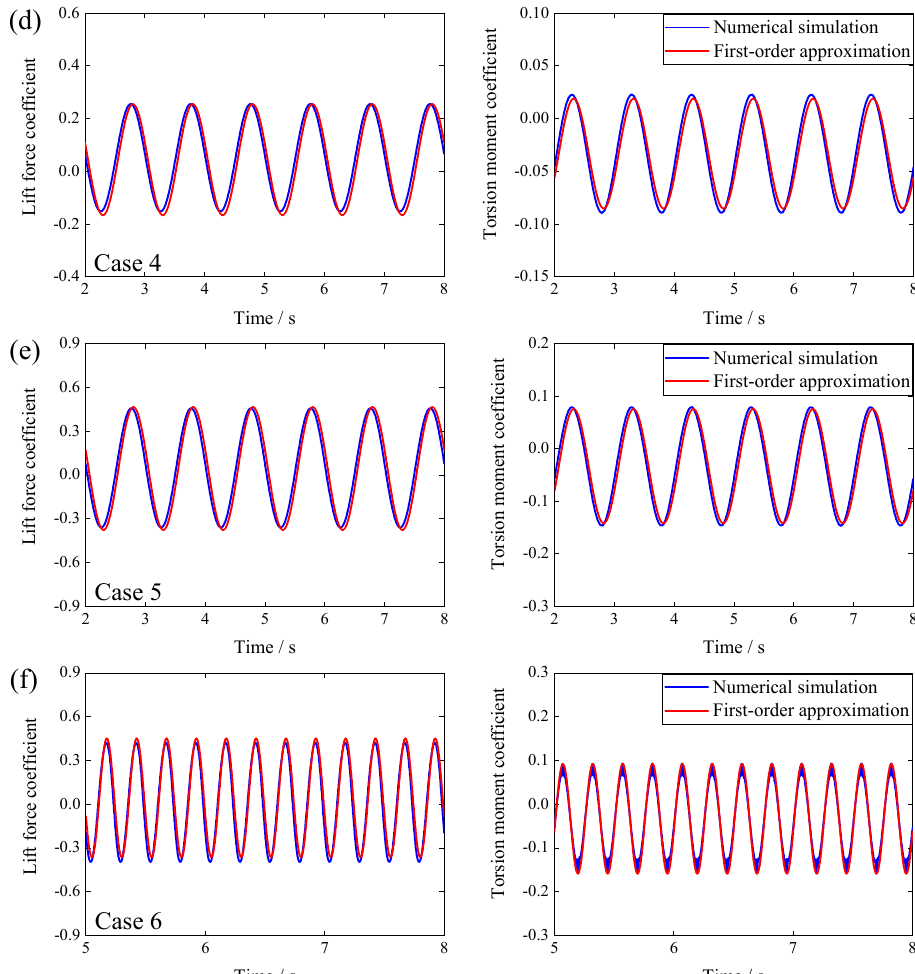
Figure 8. Comparisons of results of force coefficients ( a ) in Case 1; ( b ) in Case 2; ( c ) in Case 3; ( d ) in Case 4; ( e ) in Case 5; and ( f ) in Case 6. Table 3. Main parameters of the main deck section of